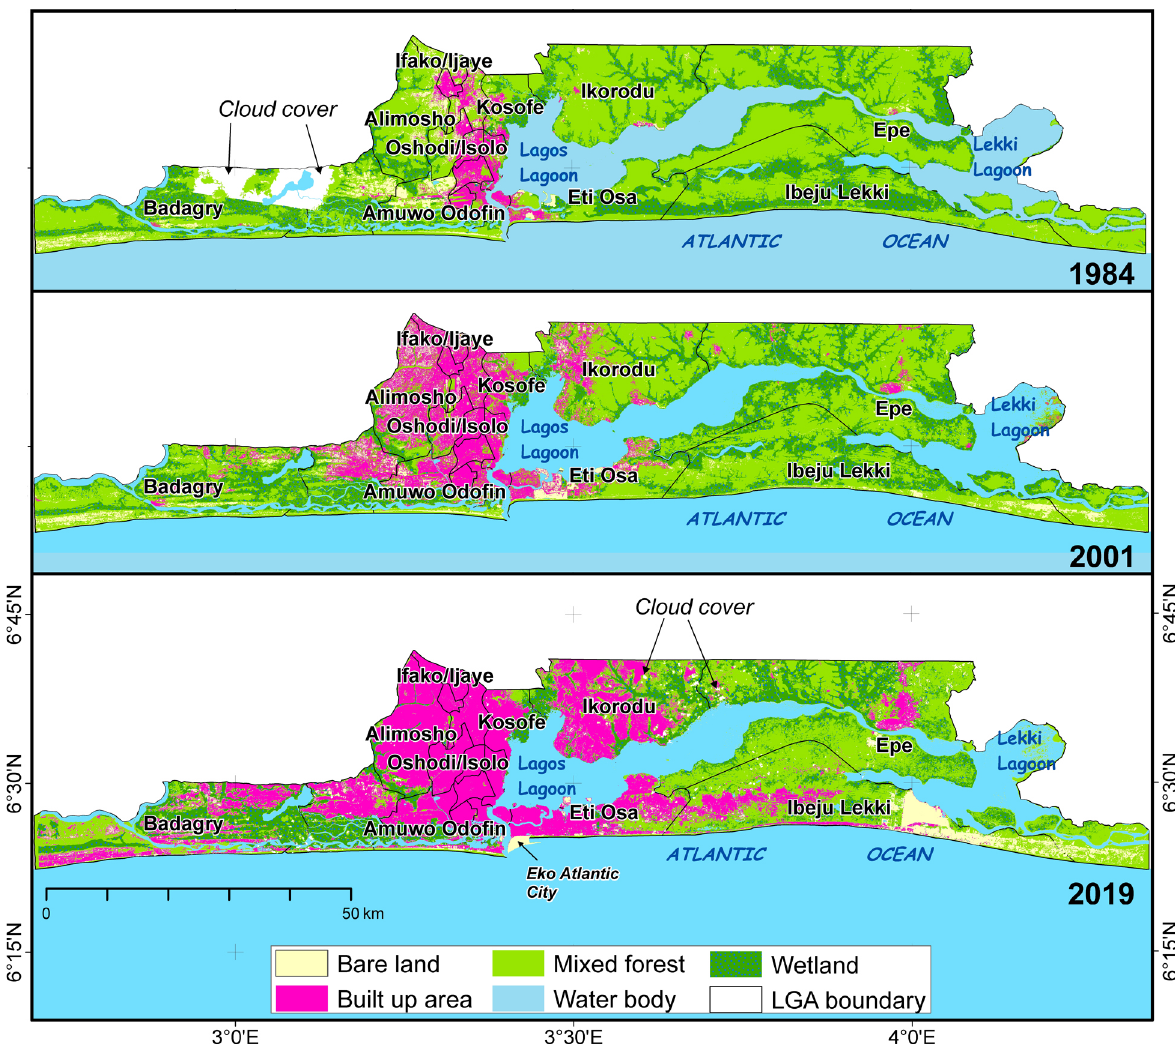
fig. 2. Spatial variation in land cover.